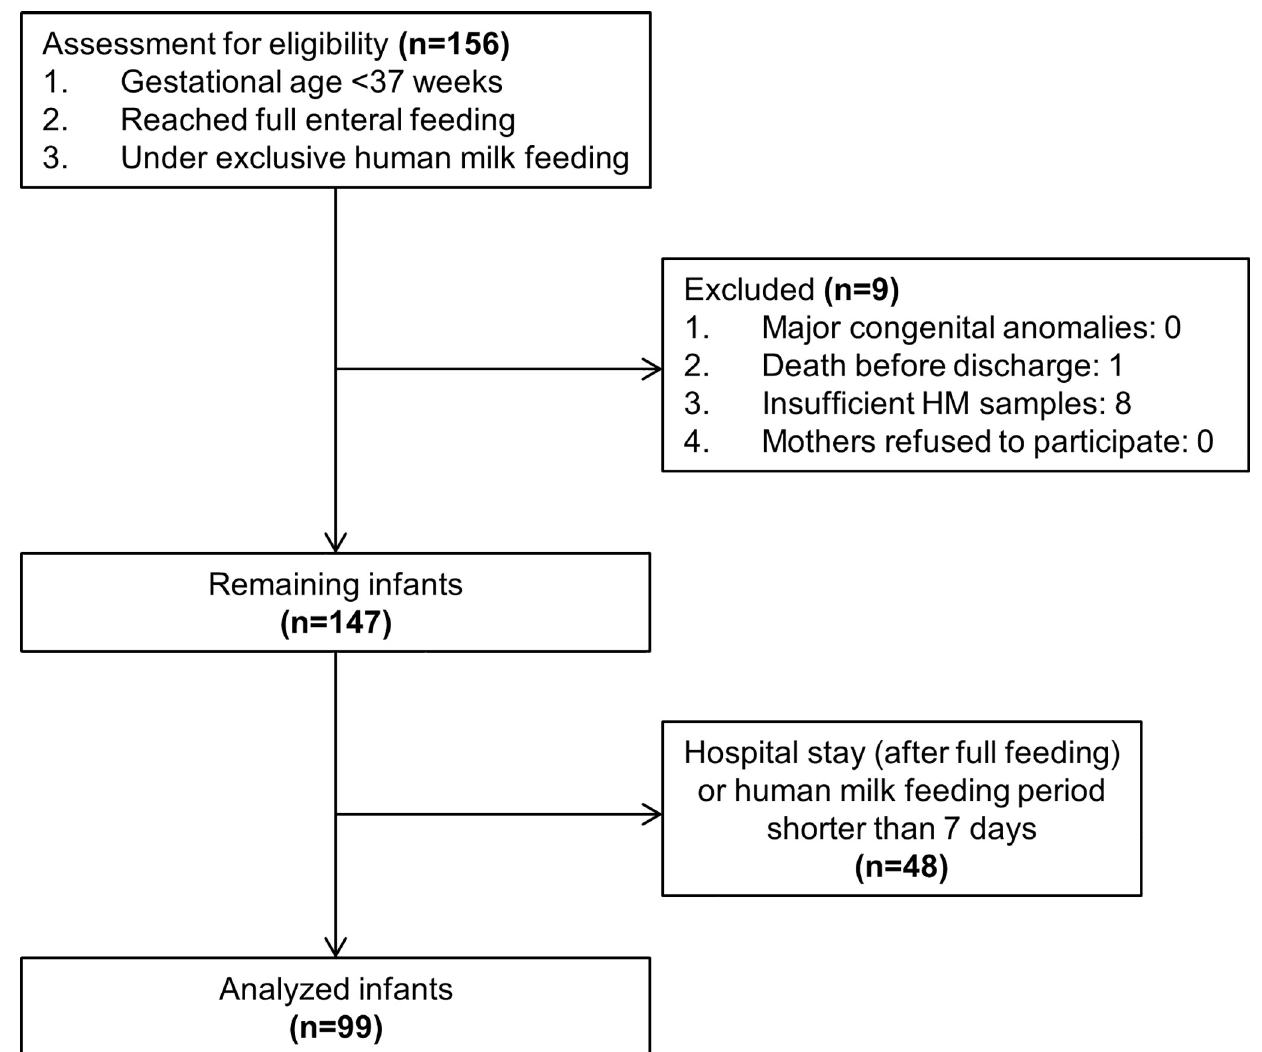
Fig 1. Participant flow through the